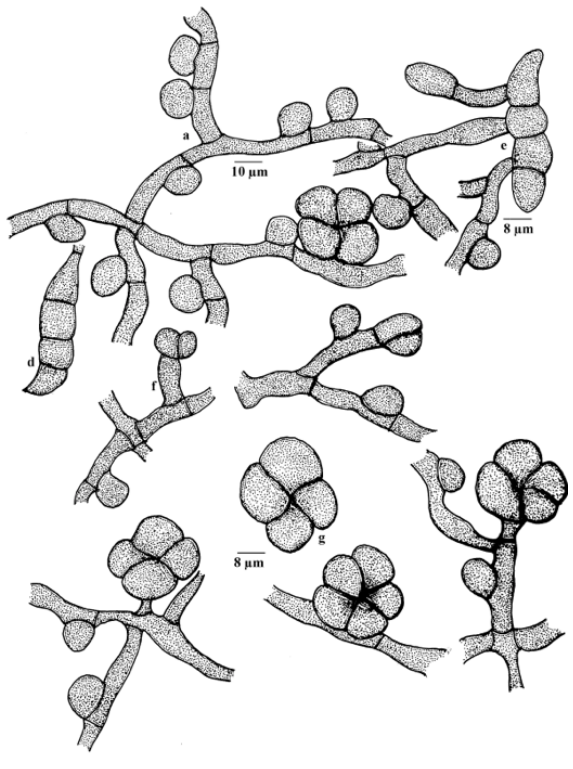
Figure 187. Sarcinella hughesii a - Appressoriate mycelium; d - Conidia of Questieriella ; g - Conidia of